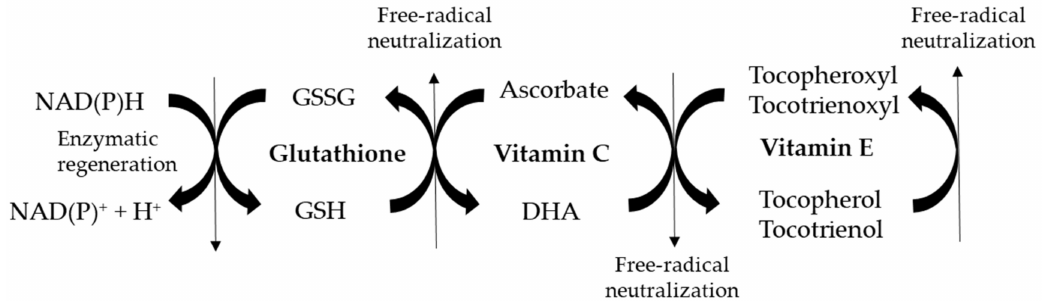
Figure 1. Schematic representation of vitamin E / vitamin C / glutathione antioxidant network involved in free-radical neutralization. GSSG: glutathione disulphide (oxidized glutathione); GSH: reduced glutathione; DHA: dehidroascorbate (reduced vitamin